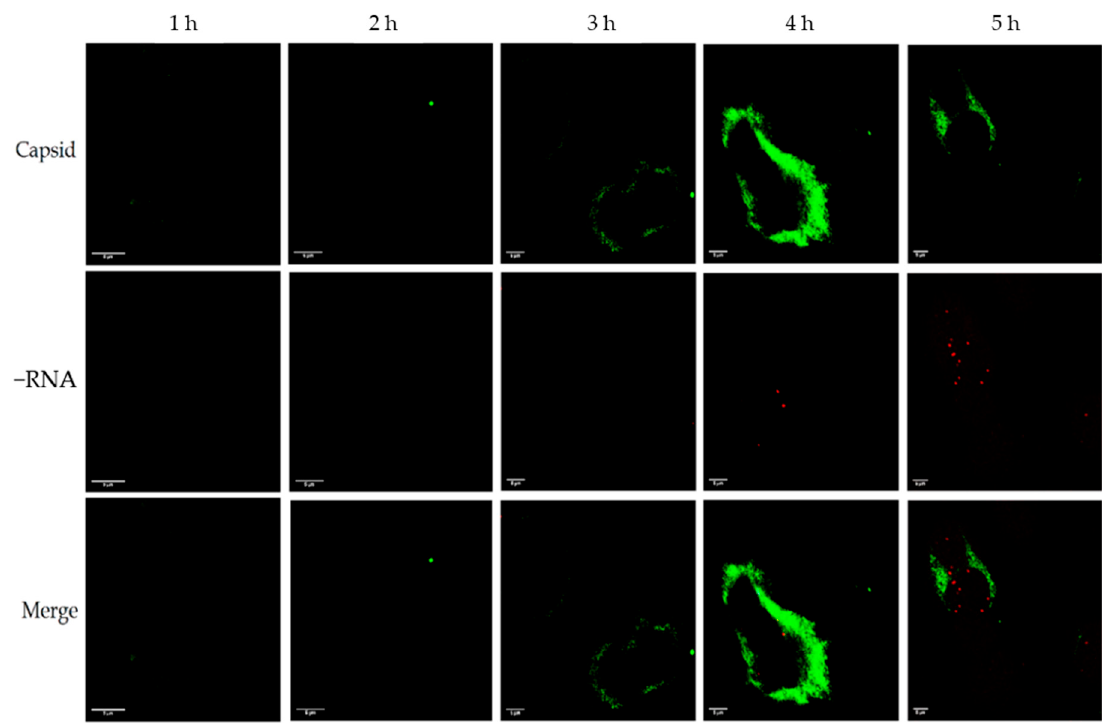
Figure 2. Distribution of viral − RNA and capsid protein in CVA9-infected cells 1–5 h p.i. The capsid protein is shown in green and the − RNA is shown in red. The rows from left to right are 1, 2, 3, 4, and 5 h p.i. Capsid protein became visible after 3–4 h p.i. and − RNA became visible at 4 h p.i. There was almost no colocalization between the capsid and the − RNA. Scale bar in every image is 5 µ